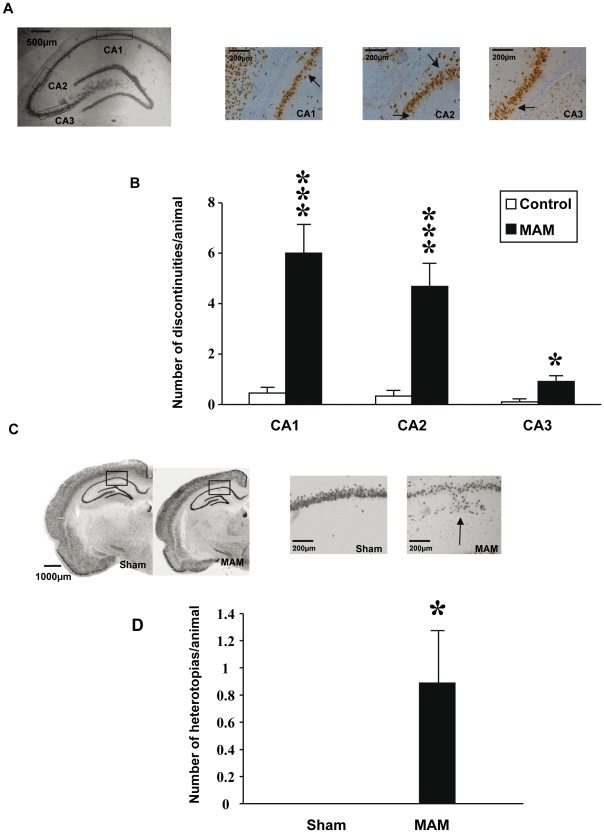
Discontinuities and heterotopias in MAM and control animals.(A) Coronal slices at Bregma −3.8mm of the hippocampus, CA1, CA2 and CA3 from MAM exposed rats stained with anti-NeuN antibody and 3,3′-diaminobenzidine as chromogen. The rectangles in the first photo indicate where the magnification shown in the three following photos comes from. Arrows point to actual discontinuities. (B) Graph bars indicating discontinuity differences between MAM rats and control animals in hippocampal subfields CA1, CA2 and CA3. (C) Coronal slices at Bregma −3.8mm from MAM and control animals stained with anti-NeuN antibody and 3,3′-diaminobenzidine as chromogen. The rectangles within the two left photos indicate where the magnification shown in the two right photos comes from. The arrow points to an actual heterotopia. (D) Graph indicating number of heterotopias in MAM rats' hippocampus compared to control animals. Results represent the mean ± S.E.M. of 9 animals per group from which slides done by duplicate were analyzed. *p<0.05 and ***p<0.001.